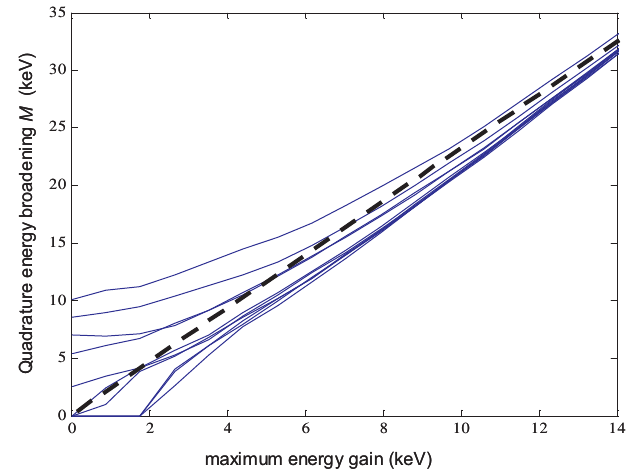
FIG. 9. (Color) Quadrature energy broadening M as a function of maximum energy gain. The solid traces correspond to calcu- lated values of M from individual electron beam energy profiles and the dashed line is a linear fit of the data through the origin.